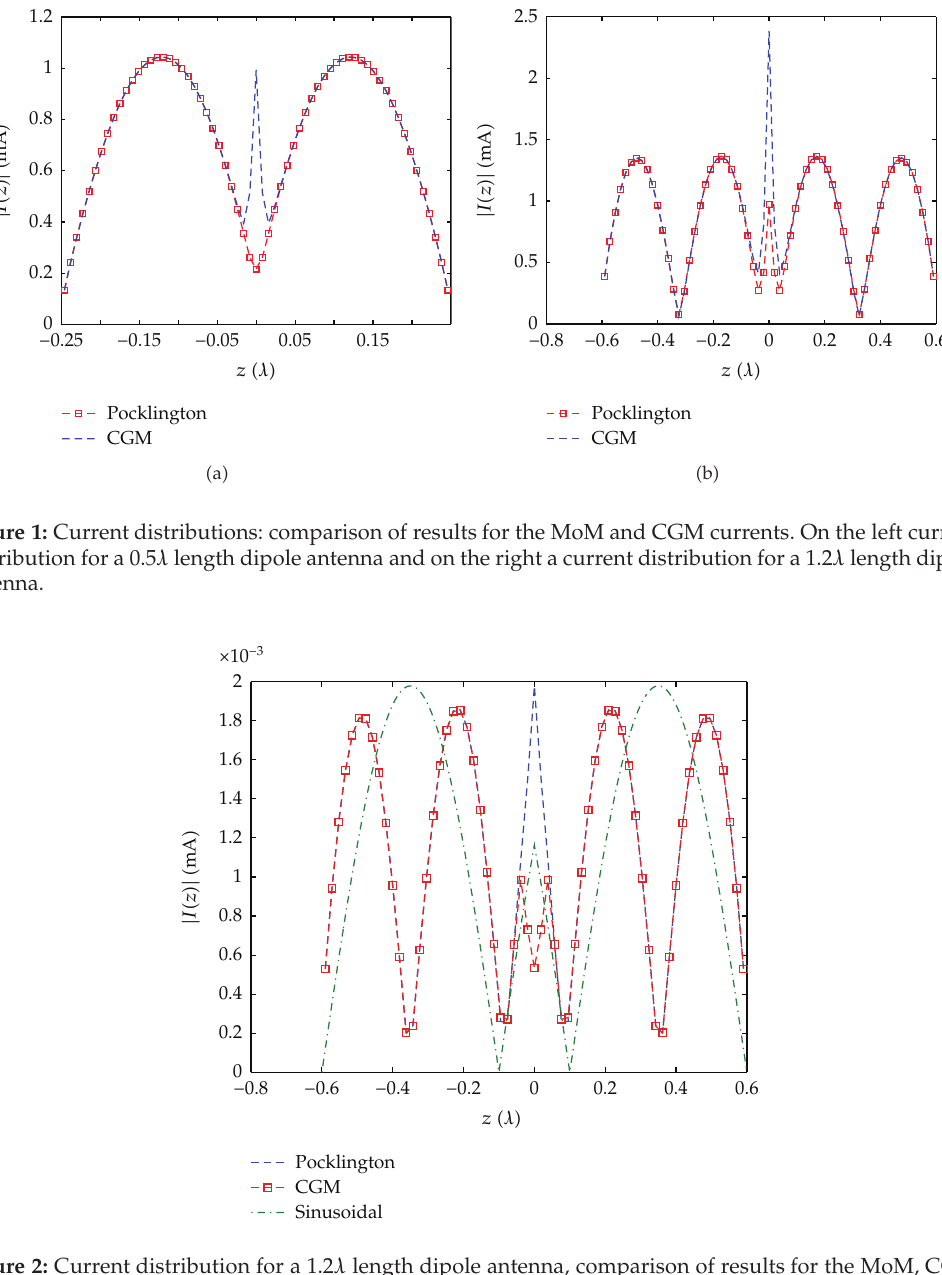
Figure 2: Current distribution for a 1 . 2 λ length dipole antenna, comparison of results for the MoM, CGM current, and sinusoidal